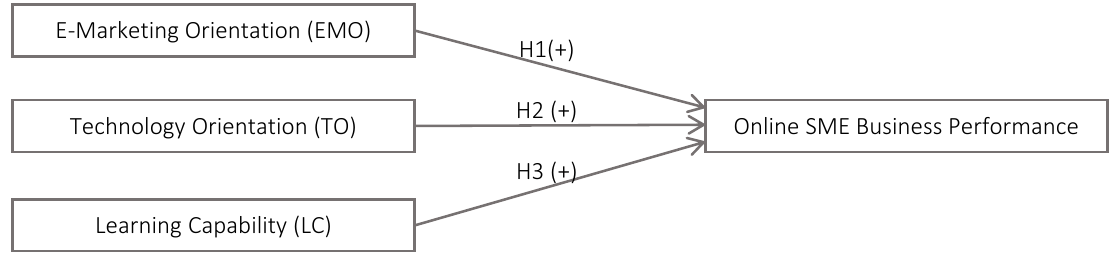
Figure 1. Research model of the